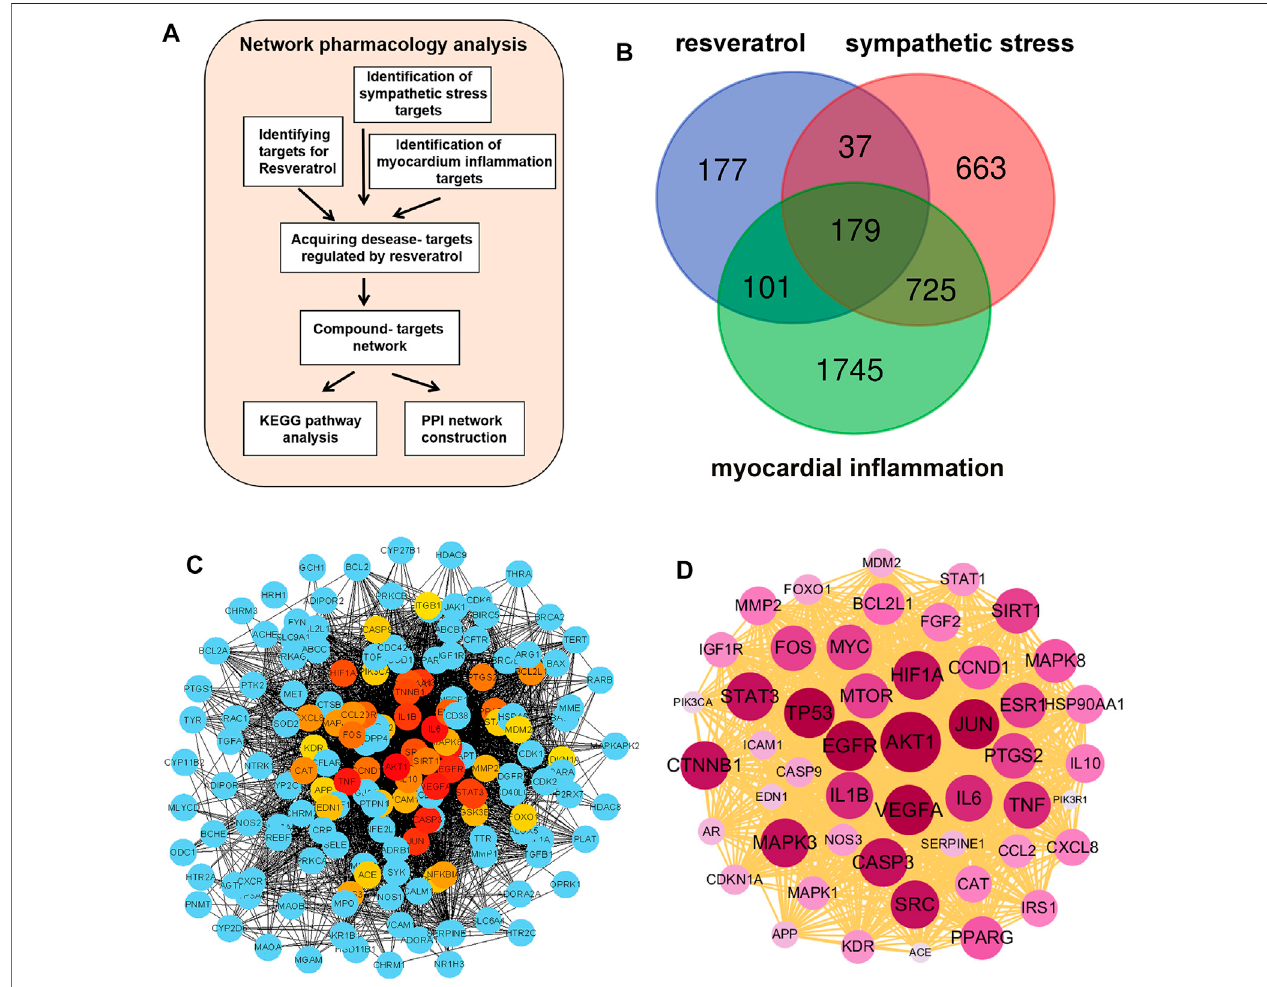
FIGURE 1 | Screening of common targets based on network pharmacology. (A) Flow chart of network pharmacology prediction. (B) Sympathetic stress targets and myocarditis targets were collected from the genecards database, and resveratrol targets were collected from the TCMSP database, SWISS target prediction database,SEAdatabase,andQSARdatabase.AftertheintersectionoftheWaynediagram, atotalof179targets wereobtained. (C) Protein-protein interaction analysis (PPI) was performed for the 179 common targets. (D) According to the degree value, the PPI was constructed using the top 50 targets.